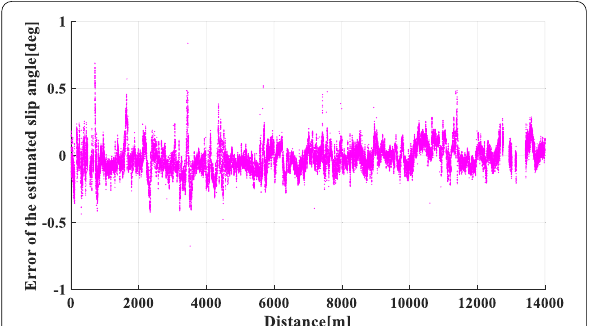
Fig. 14 Estimated slip angle (Urban street)